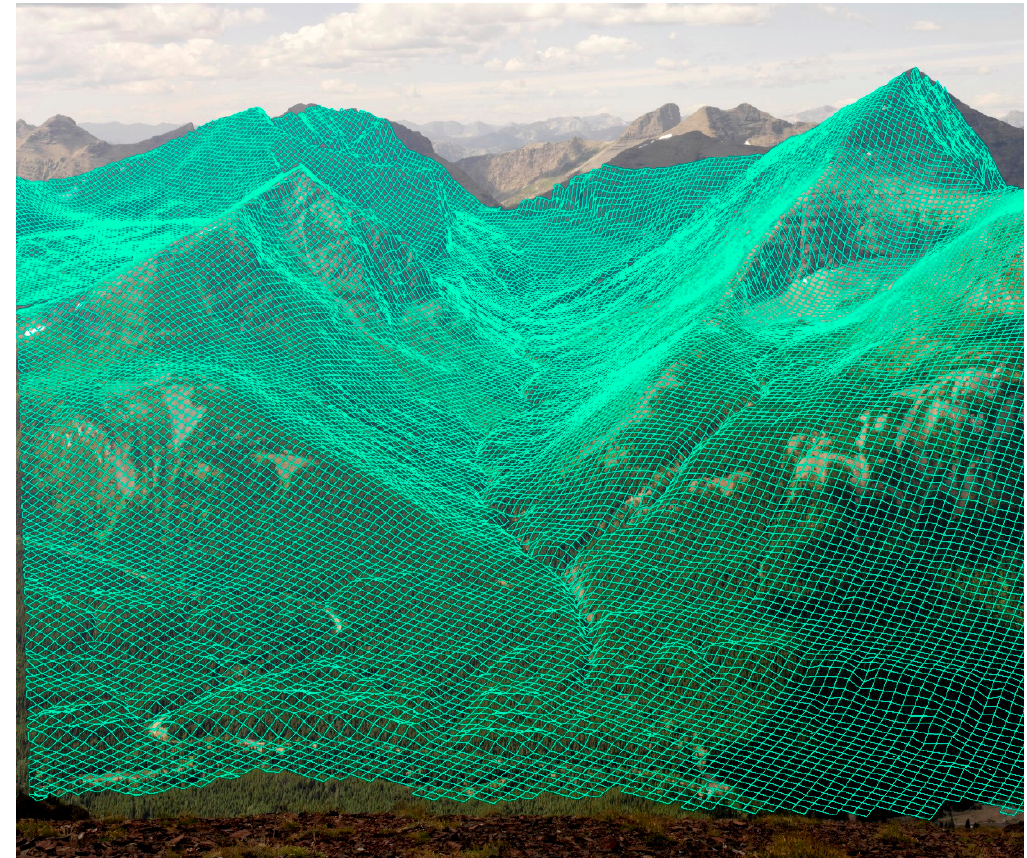
Figure 3. Fishnet vector layer, developed using the WSL monoplotting tool, draped on an oblique image. Each cell in the fishnet represents a 20 × 20 m area, viewed orthogonally.